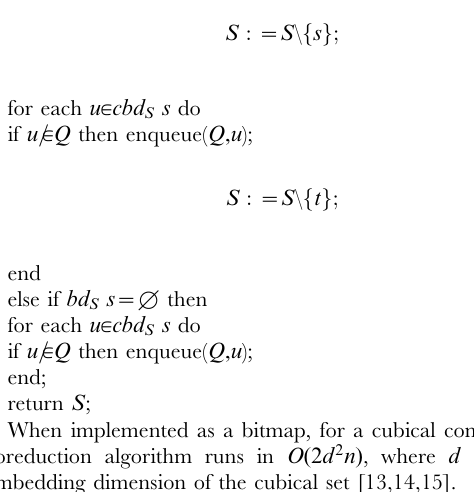
Figure S2 Each figure is a Mathematica : nb file contain- ing a 3-D figure. These figures depict the medium + small point cloud; the medium + small point cloud with the computed generators; and the medium + small point cloud with computed generators and containing the black marked-double-circle, whose arclength can is parameterized by the response angle of the afferent hairs.